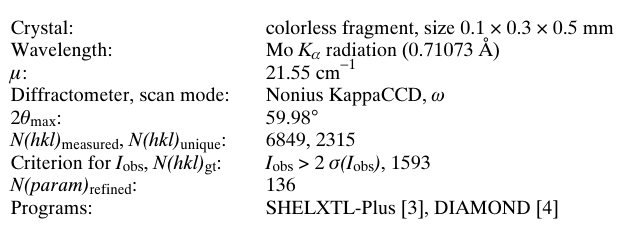
Table 1. Data collection and